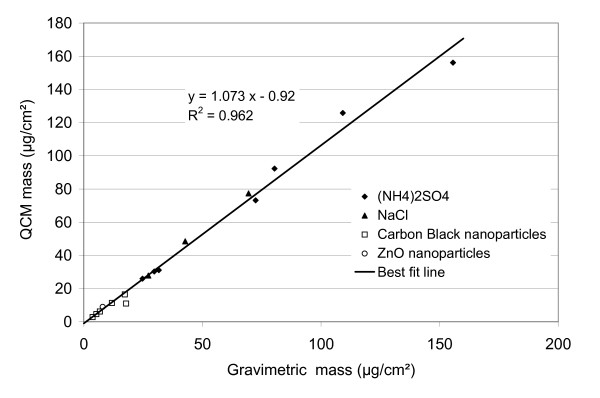
Comparison of quartz crystal and gravimetric microbalance. Measurement of the mass deposited on the bottom plate of the ALICE by QCM and gravimetric analysis after nebulization of 1-5 mL of (NH4)2SO4, NaCl, carbon black and ZnO solutions/suspensions with concentrations ranging between 2-10% (salts) and 0.1-2% (carbon black and ZnO nanoparticles). The (dry) mass per surface area as determined by QCM and gravimetry showed excellent linearity (R2 = 0.962) and agreement within 7.3% (slope) over the investigated range from 3 to 160 μg/cm2.